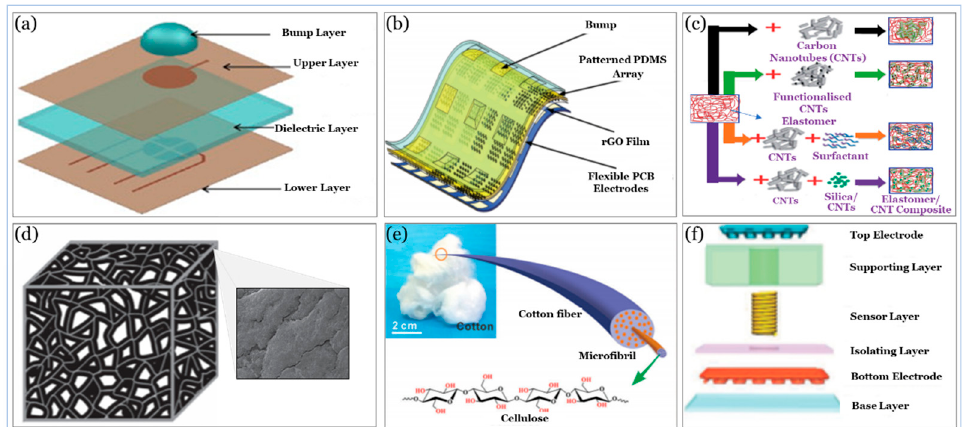
Figure 8. Substrate design and fabrication. ( a ) Bumpy design with PDMS substrate. Reproduced with